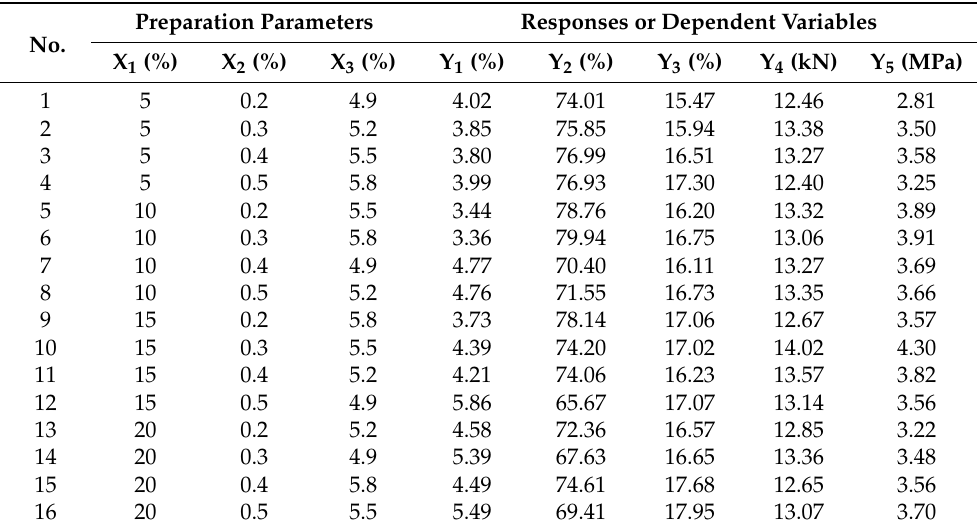
Table 6. Orthogonal results of asphalt mixtures containing diatomite and basalt fibre [53].